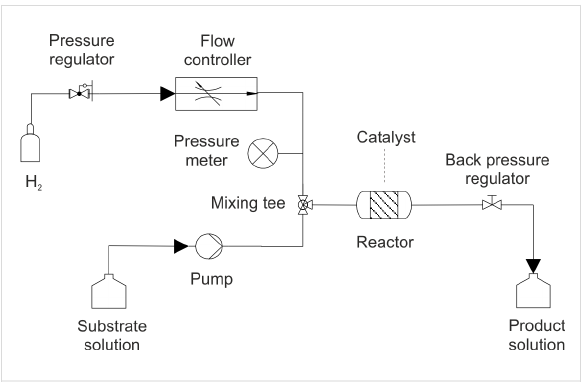
Figure 3: Sketch of typical continuous flow apparatus for liquid-phase catalytic alkynes hydrogenation